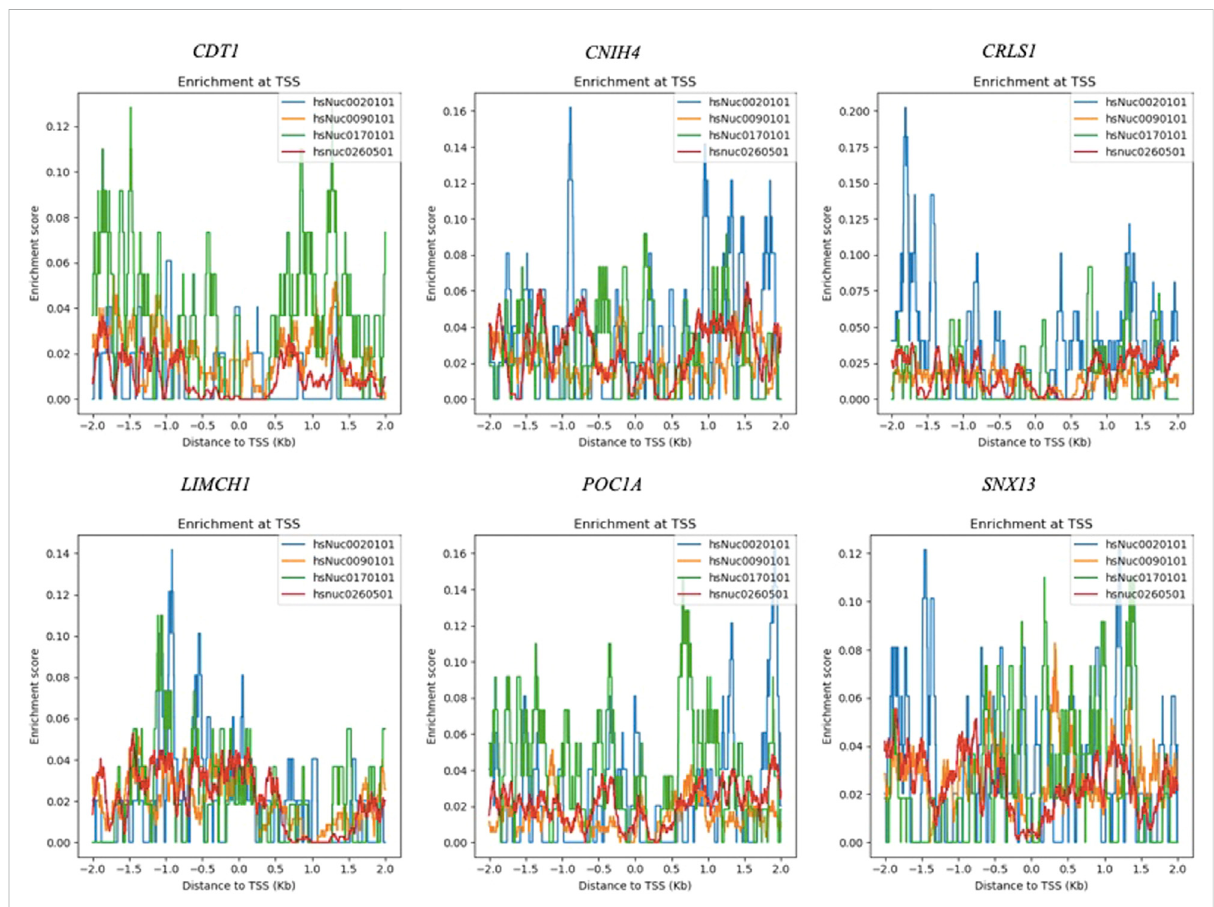
FIGURE 7 Nucleosome enrichment maps of novel candidate genes at K-562 (hsNuc0260501), COLO829 (hsNuc0020101), HeLa (hsNuc0170101), and MCF-7 (hsNuc0090101)